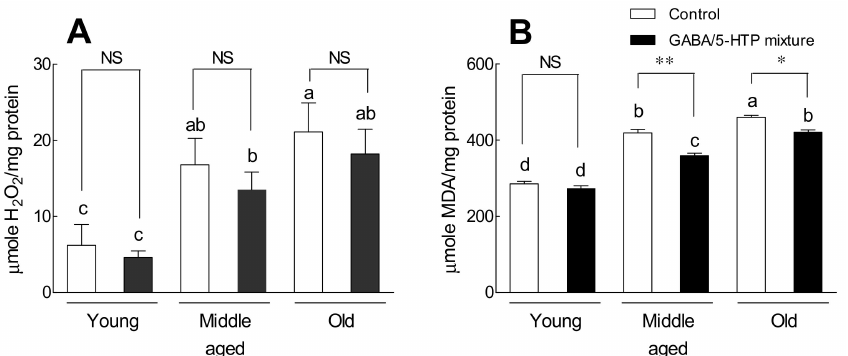
Figure 7. Effects of the GABA/5-HTP mixture (60 and 6 mg/kg, respectively, oral administration for 14 days) on age-related changes in the amount of hydrogen peroxide ( A ) and lipid peroxidation ( B